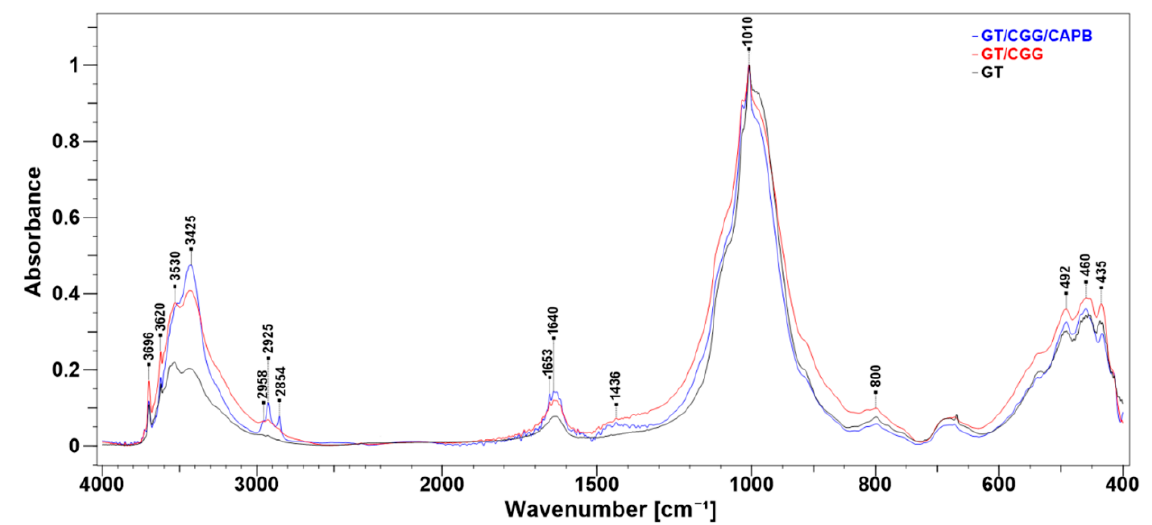
Figure 11. FTIR spectra of natural clay (GT) and composites: GT/CGG and GT/CGG/CAPB. All spectra were normalized on the band at 1010 cm − 1 .